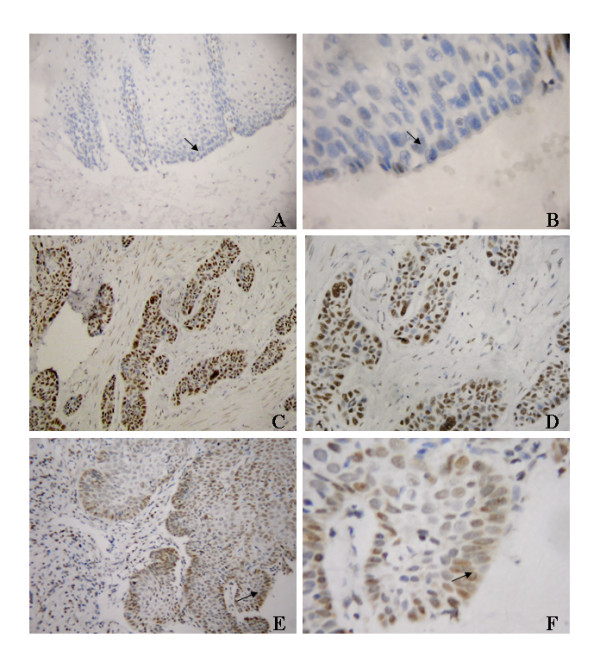
Expression of Bmi-1 protein in tissue by immunohistochemistry. A and B, only weak staining of Bmi-1 was detected in few normal esophageal epithelial tissue (arrow, normal epithelial cells). C and D, positive expression of Bmi-1 in esophageal carcinoma tissues (200× and 400× of magnification, respectively). E and F, representative case of higher expression of Bmi-1 in invasive front (arrow, 200× and 400× magnification, respectively). Bmi-1 expression mainly localized in nuclei of tumor cells.